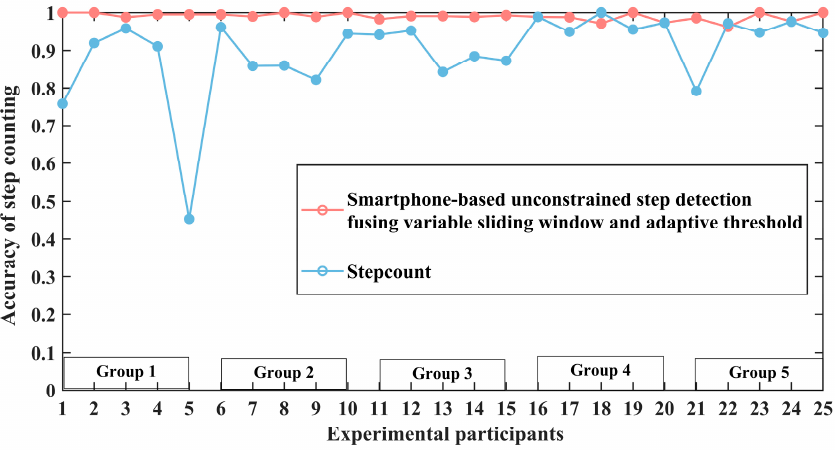
Figure 14. Step counting accuracy in constrained state.